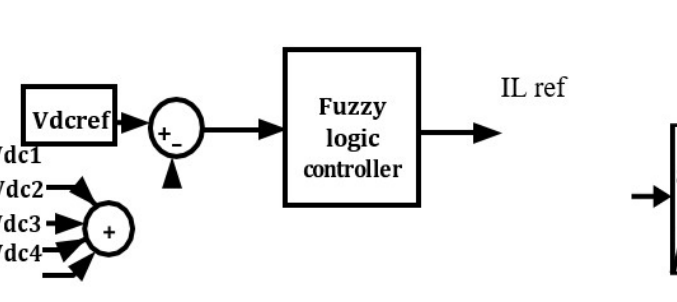
Figure 2. Block Diagram of Proposed DC Link Voltage Controller.